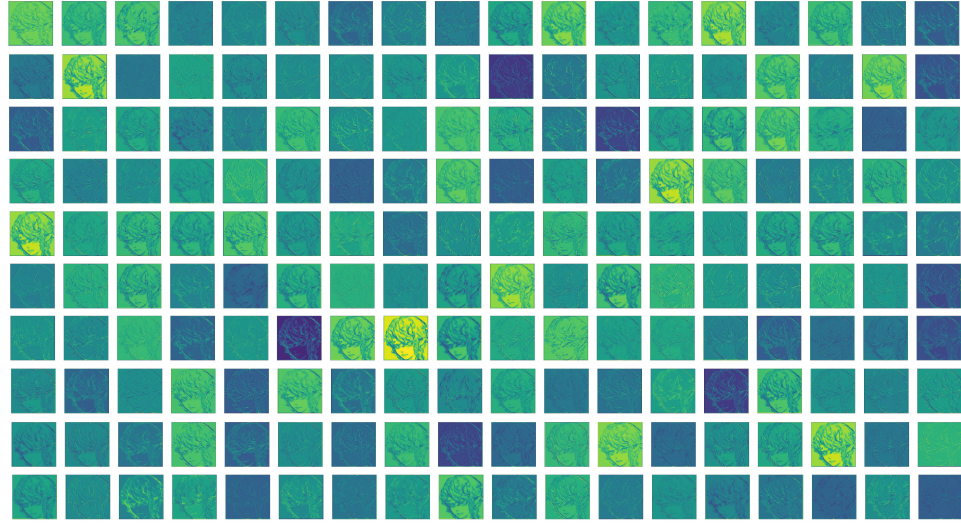
Figure 14. Deep feature